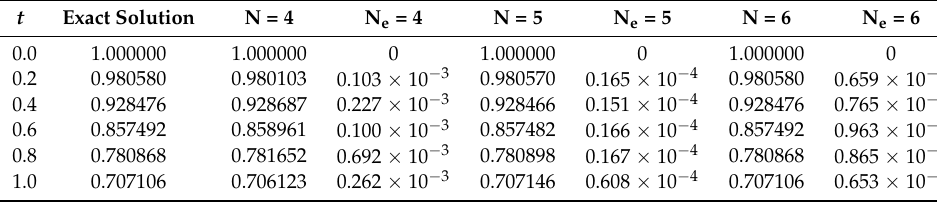
Table 5. Numerical result for approximate solution of y 2 ( t ) in Example